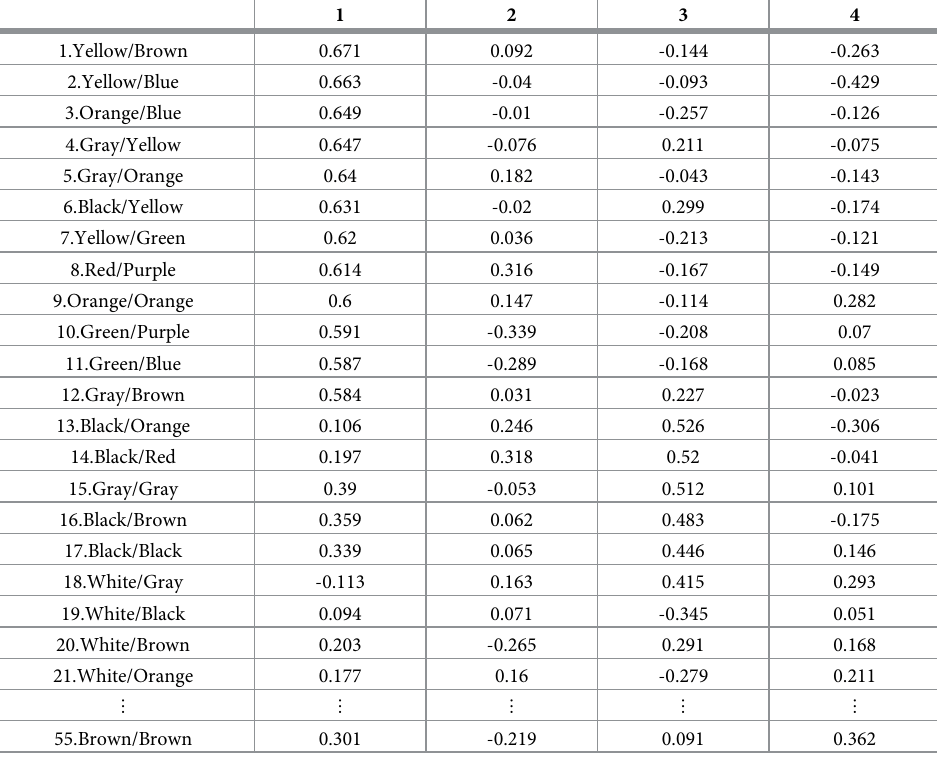
Table 5. Single-factor analysis component